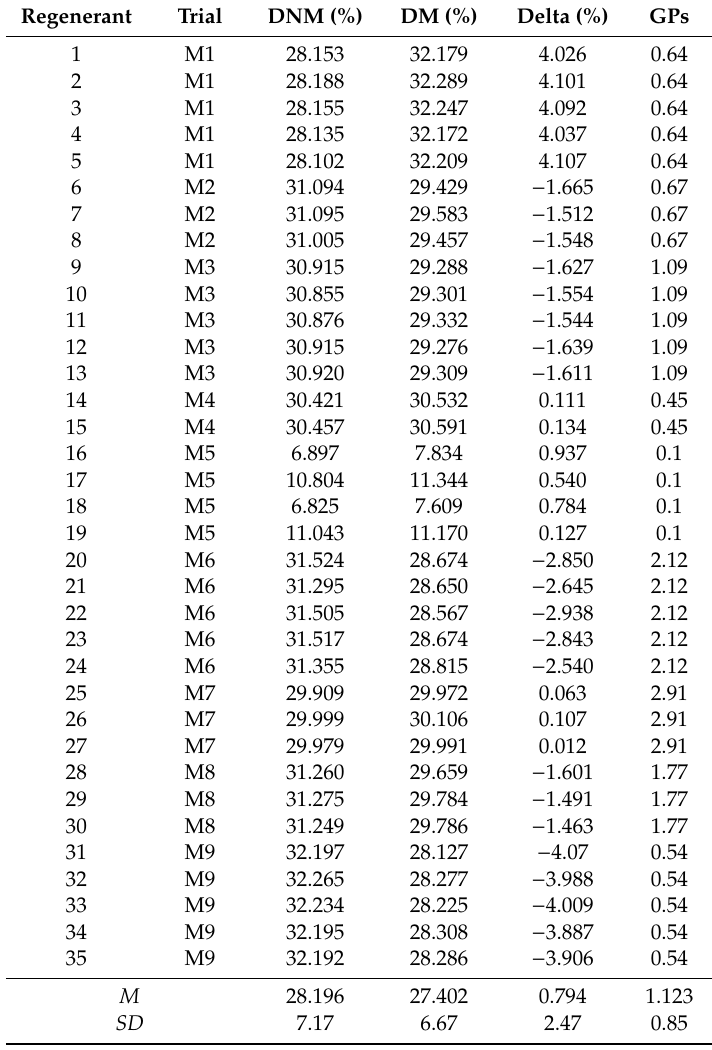
Table 1. The arrangement of de novo DNA methylation (DNM) and DNA demethylation (DM) quantitative characteristics evaluated based on DArTseqMet markers exploiting a semi-quantitative Methylation Sensitive Amplification Polymorphism (MSAP) approach using DNA samples of anther culture regenerants derived under the varying concentration of copper and silver ions in the medium and under distinct time of anther cultures (trials M1–M9). The number of green plants regenerated per 100 anthers (GPs) under the nine trials is also indicated, whereas Delta is the di ff erence between demethylation and de novo methylation (DM-DNM). Mean ( M ) and standard deviation ( SD ) are also